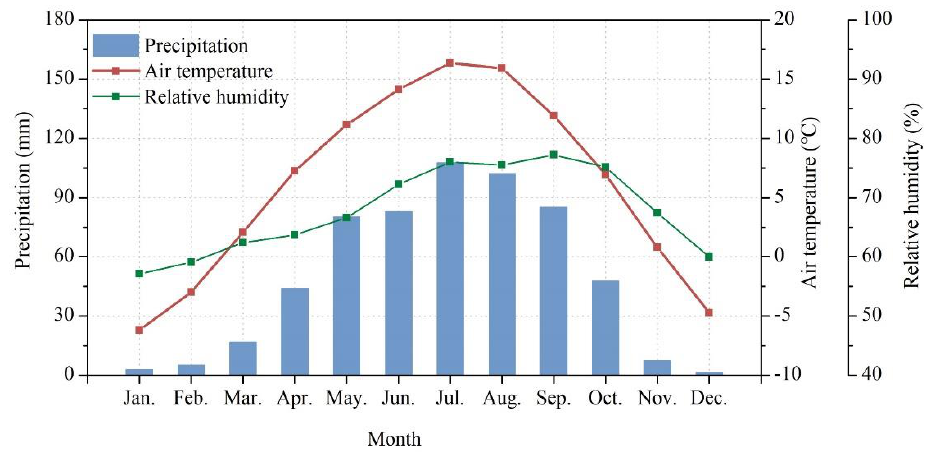
Figure 2. Multi-year averages of seasonal patterns of precipitation, air temperature and relative hu- midity in Minxian (1961 – 2020).